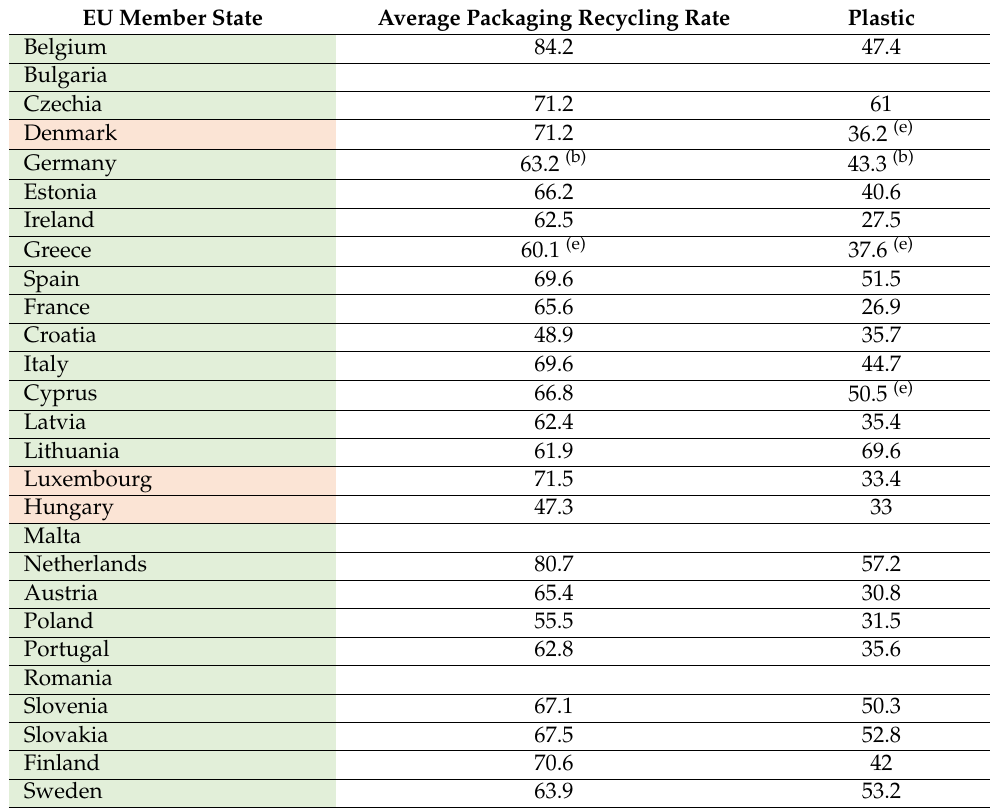
Table 4. Recycling rates of plastic packaging waste for monitoring compliance with policy targets [127,150]. EU Member State Average Packaging Recycling Rate